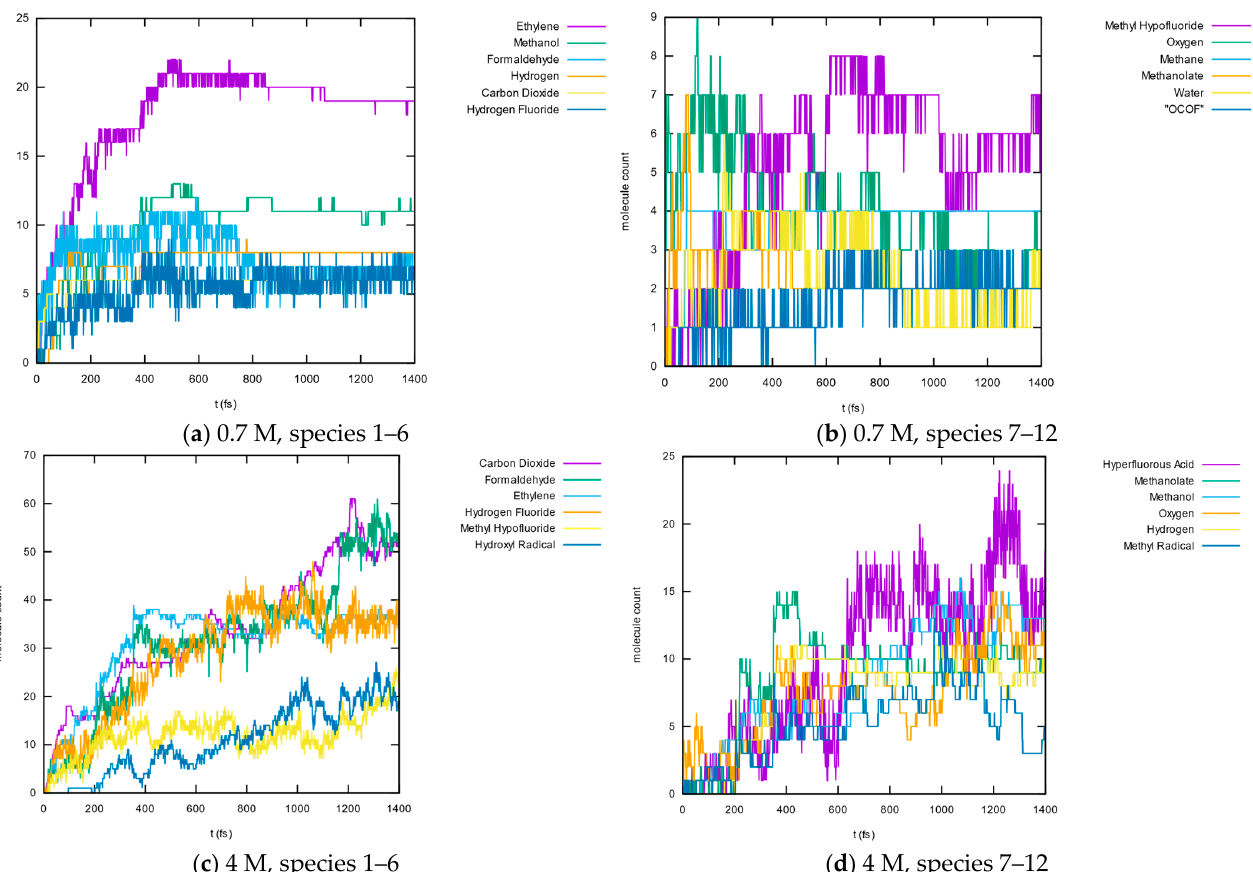
Figure 11. Time-dependent abundancies of different molecules during the dynamics of both systems. The ordering of the molecules is the same as in Figure 10: species 1–6 at 0.7 M ( a ), species 7–12 at 0.7 M ( b ), species 1–6 at 4 M ( c ), species 7–12 at 4 M ( d